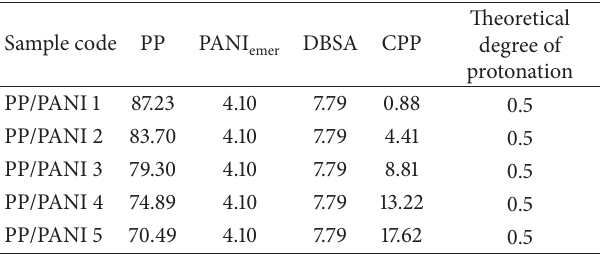
Table 1: Formation of PP/PANI composition (in wt %).